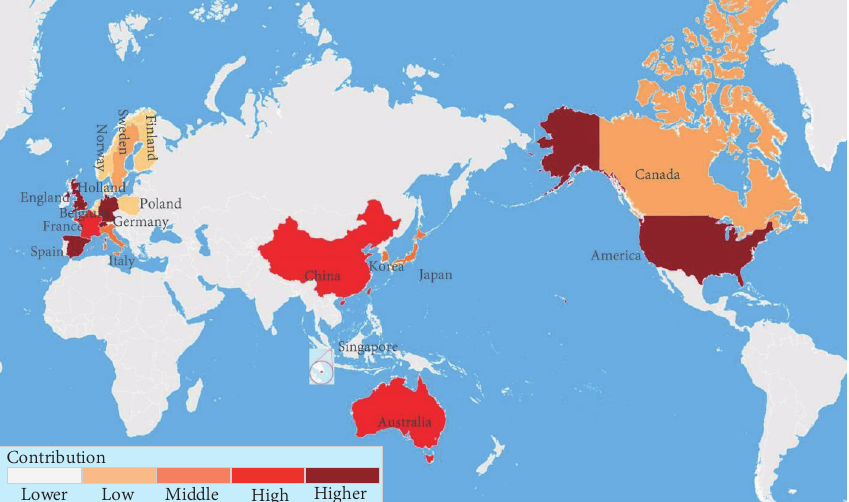
Figure 8. Contribution of different countries in the SLAM field(Colors from light to dark indicate contributions from low to